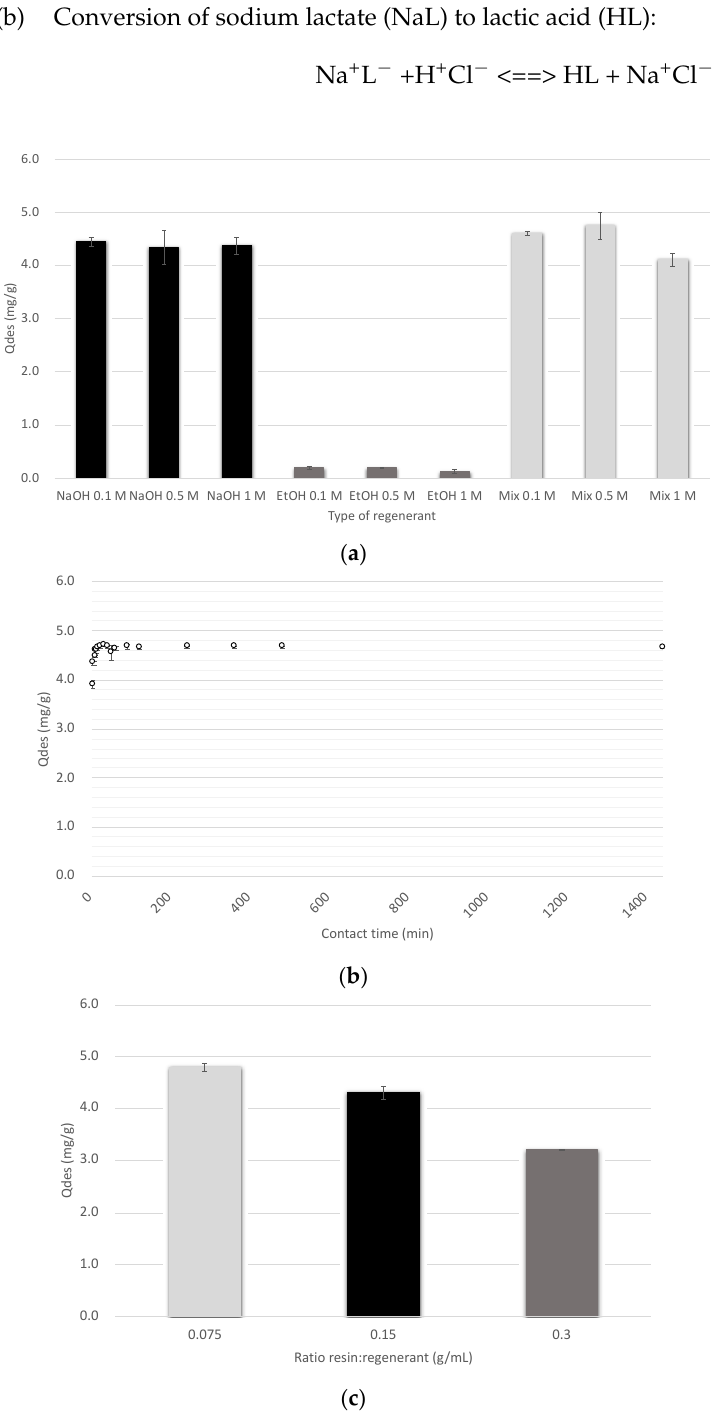
Figure 5. Effect of ( a ) type of regenerant, ( b ) contact time and ( c ) solid/liquid ratio in the desorption process of lactic acid by A100 resin.